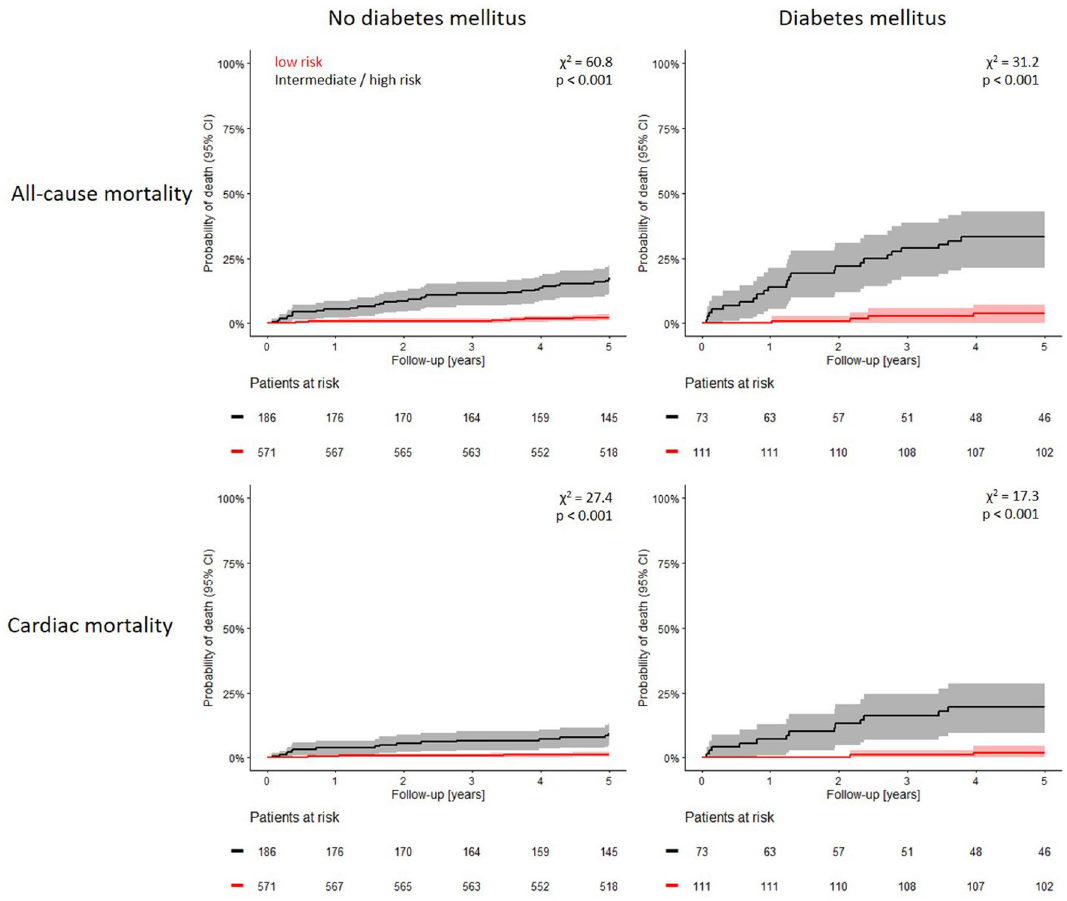
Figure 4. All-cause and cardiac death in patients with and without diabetes mellitus. Comparison of Kaplan– Meier probabilities of all-cause death (top panels) and of cardiac death (bottom panels) in the population subgroups defined by the Polyscore as low risk (red) and intermediate/high risk (black). The analyses were repeated separately for patients without the diagnosis of diabetes mellitus (left panels) and for patients with the diagnosis of diabetes mellitus (right panels). Numbers of patients at risk in the individual sub-groups are shown below the time axes. In all presented subsets, the differences between the probabilities of death were statistically significant. χ 2 chi-square, 95% CI 95% confidence